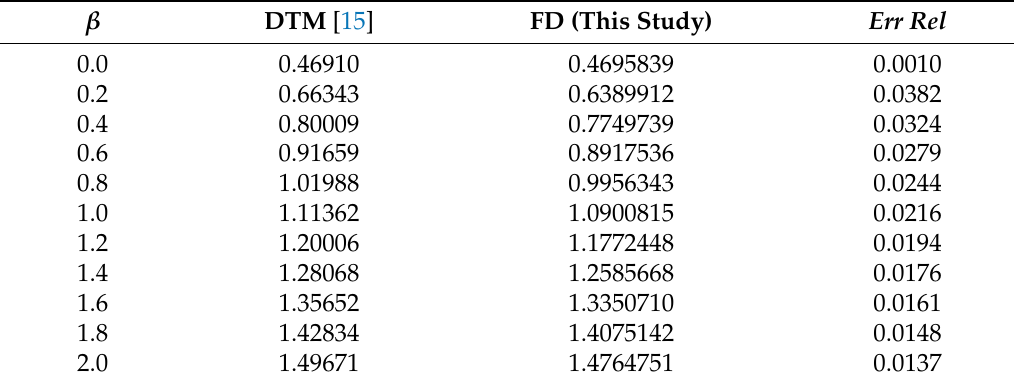
d 2 u ( 0 ) , and comparison with results by [15]. dx 2